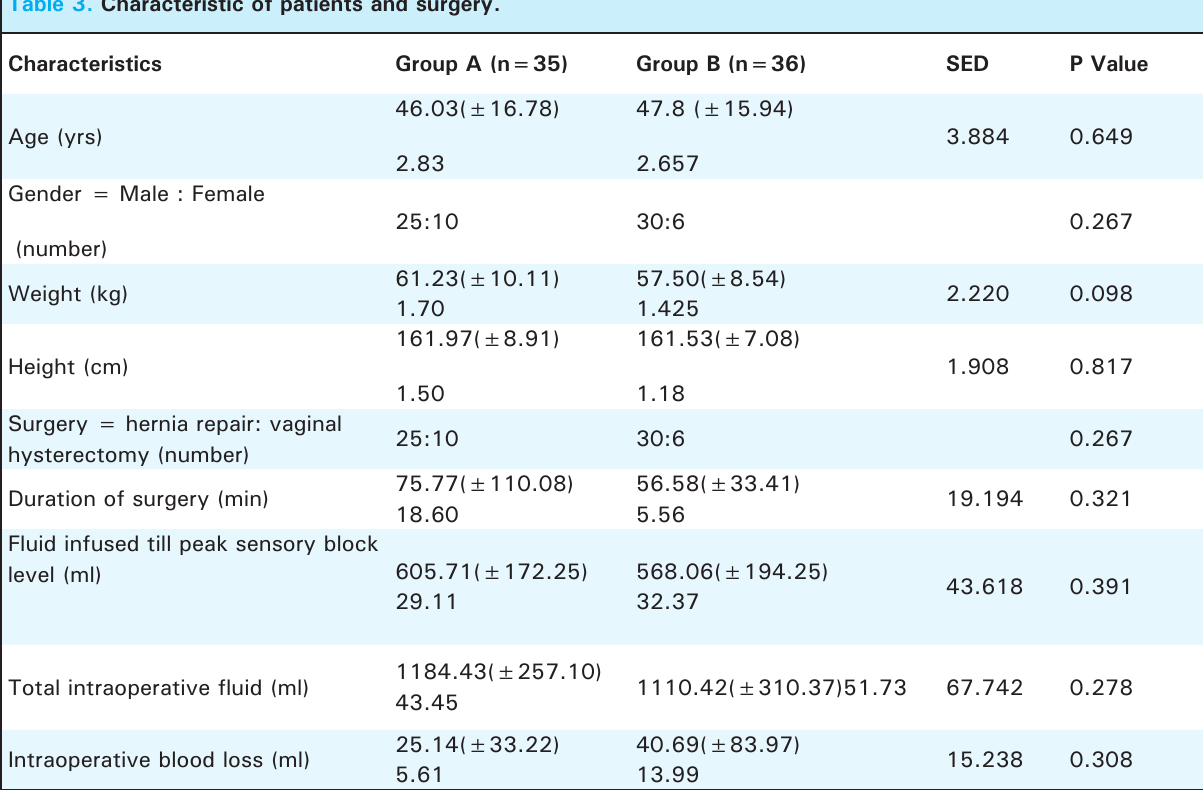
Table 3. Characteristic of patients and